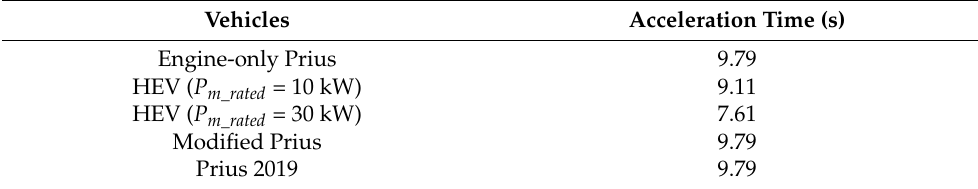
Table 10. Acceleration time from 0 to 60 mph for Prius-based